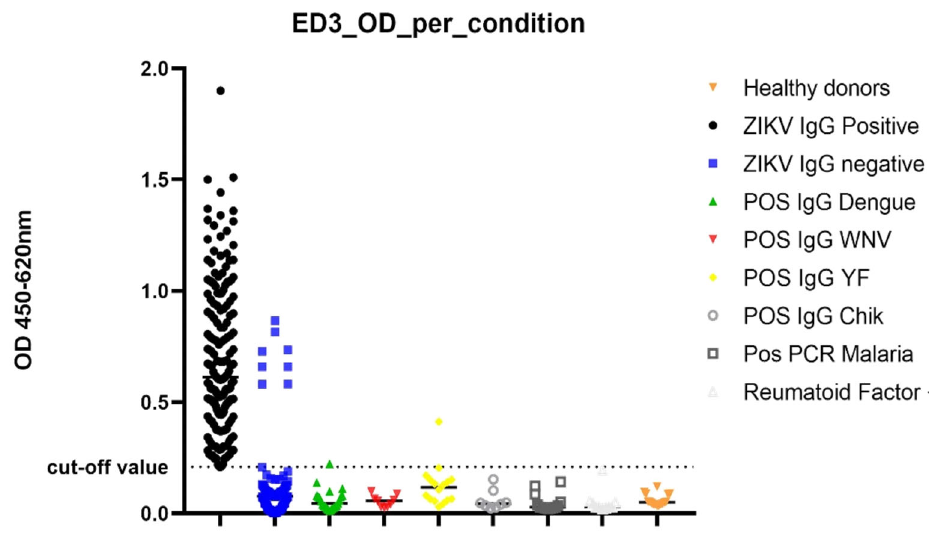
Figure 4. OD distribution per condition.